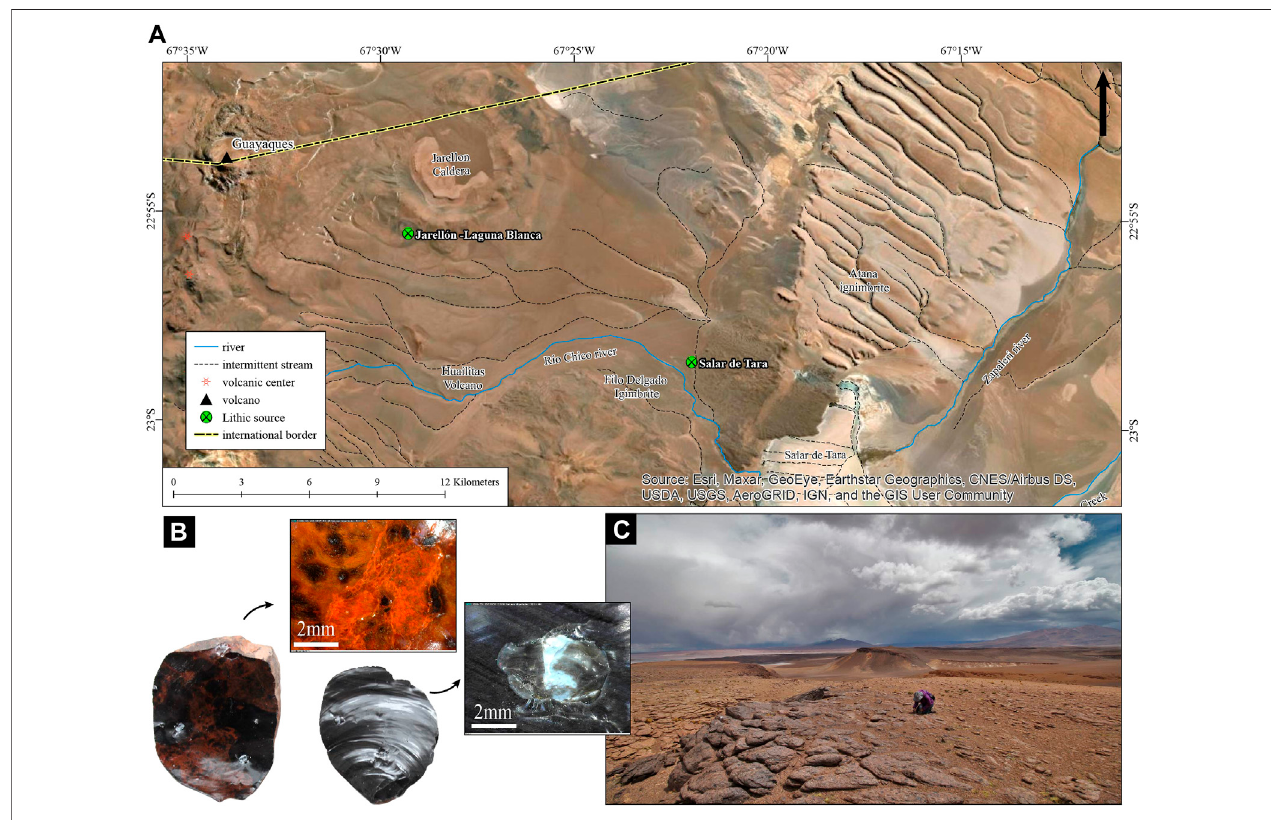
FIGURE 6 | Jarellón-Laguna Blanca source: (A) geological context; (B) raw material sample; (C) scatter area of obsidian samples.